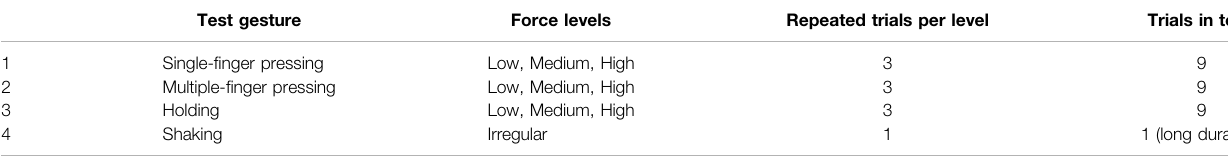
TABLE 3 | Experiment procedure for validating contact area.